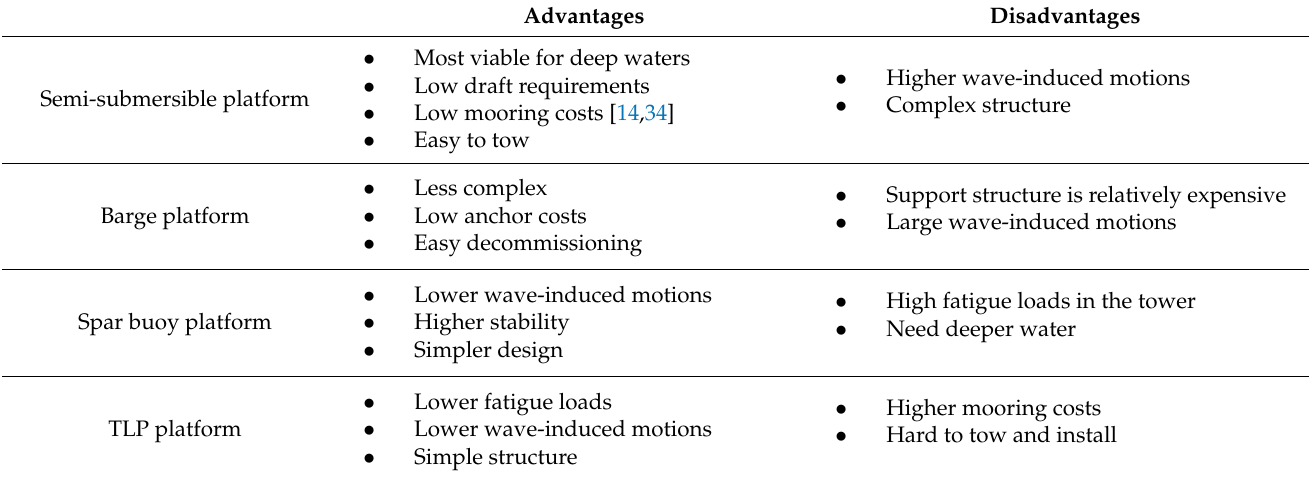
Table 1. Comparison of different offshore floating